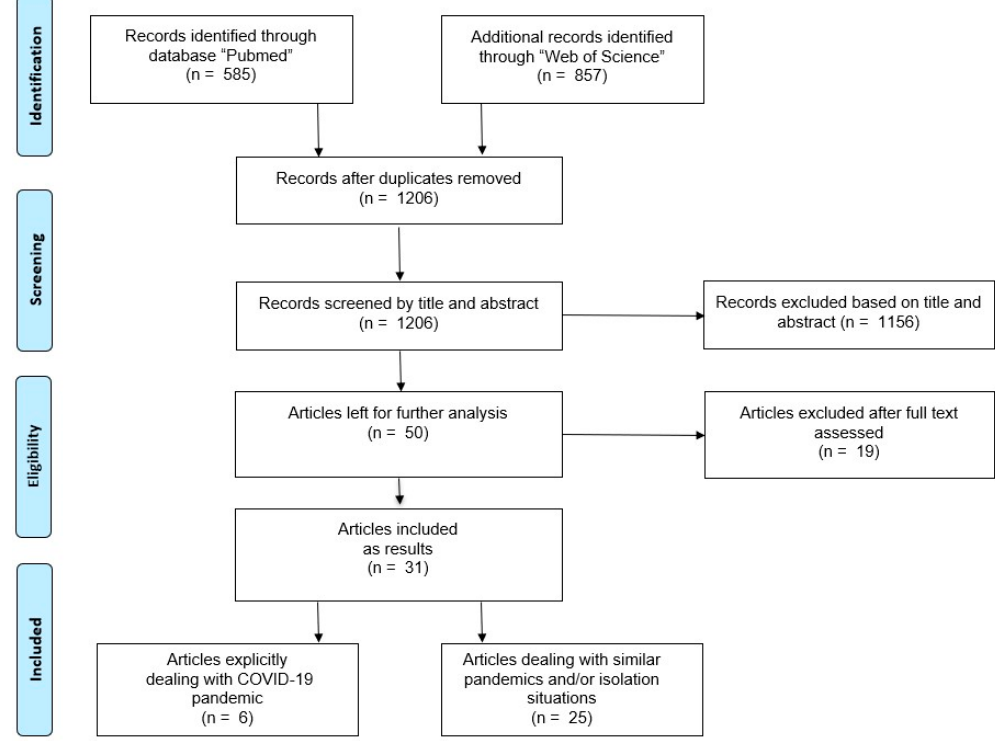
Figure 1. Results of literature search for physical activity during pandemics.